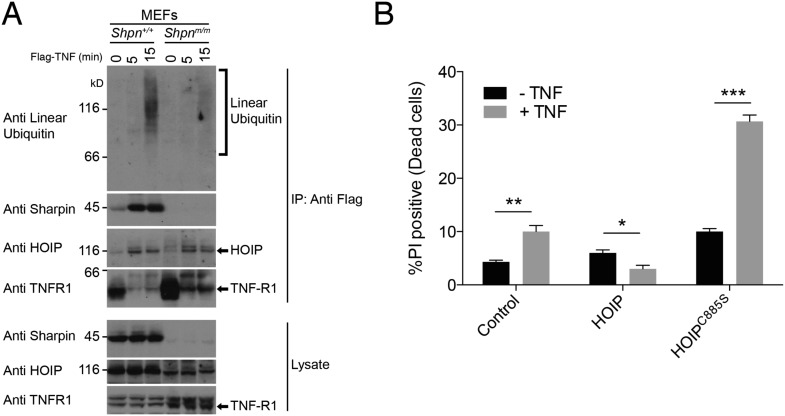
Sharpin is required for normal linear ubiquitylation of the TNF-R1 signaling complex, and HOIP protects keratinocytes from TNF-induced cell death.(A) Anti Flag Immuno-Precipitation (IP) of the TNF receptor signaling complex in immortalised mouse embryonic fibroblasts (MEFs) treated with Flag-TNF for the times indicated. (B) HaCaT human keratinocytes stably expressing HOIP, the catalytically inactive HOIPC885S, or an empty vector (control) were treated with 100 ng/ml TNF for 24 hr. Viability was assessed by propidium iodide (PI) uptake and flow cytometry. Data are presented as mean + SEM, n = 3, *p ≤ 0.05, **p ≤ 0.01, ***p ≤ 0.005.